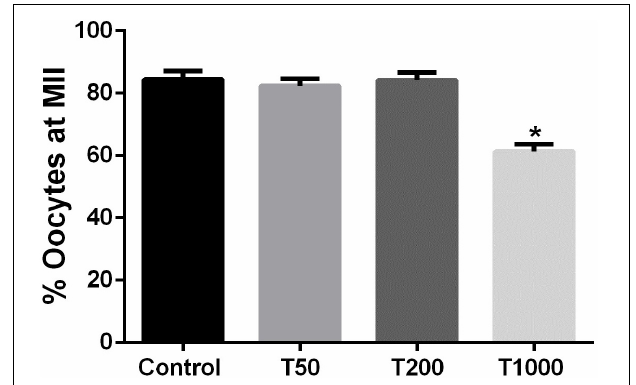
FIGURE 2 | Effect of TUDCA concentrations on the proportion of oocytes that reached the MII stage during IVM. Results are represented by means ± SEM of five replicates using 87–110 COCs/treatment. The bar marked with asterisk differs significantly ( P ≤ 0.06). Control, 0 µ M TUDCA; T50, 50 µ M TUDCA; T200, 200 µ M TUDCA; T1000, 1,000 µ M